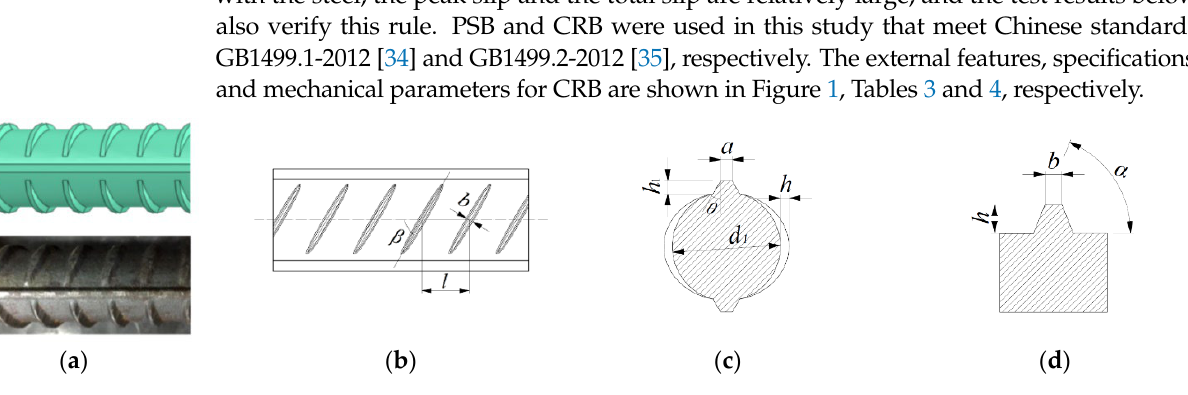
Figure 1. The bar with crescent-shaped rib and its geometrical features. ( a ) Three-dimensional photograph; ( b ) top view; ( c ) cross-section; ( d ) crescent-shaped rib. Table 3. The geometrical parameters of CRB (mm).